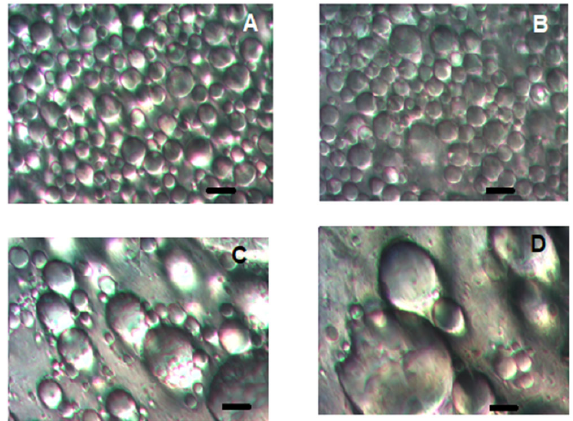
Figure 1. ( A ) unloaded bigel; ( B ) Bigel loaded (500 µ g/mL extract of Q. resinosa ); ( C ) Bigel loaded (1000 µ g/mL extract of Q. resinosa ); ( D ) Bigel loaded (2000 µ g/mL extract of Q. resinosa ). 100 × , scale bar size 200 μ m.